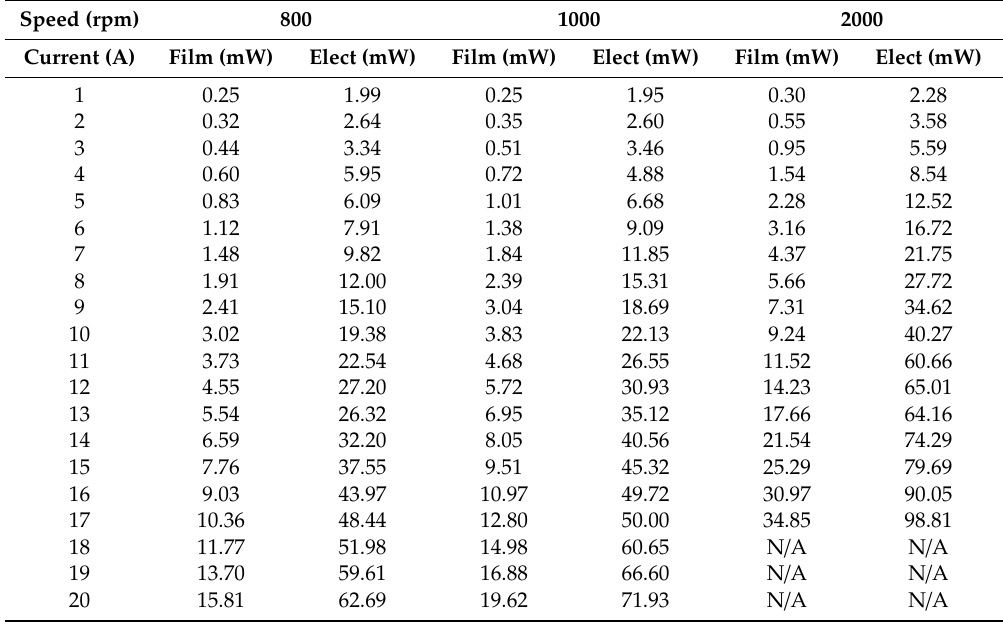
Table 7. Comparative results of losses in the two capacitors at a speed range of 3000–6000 rpm. Speed